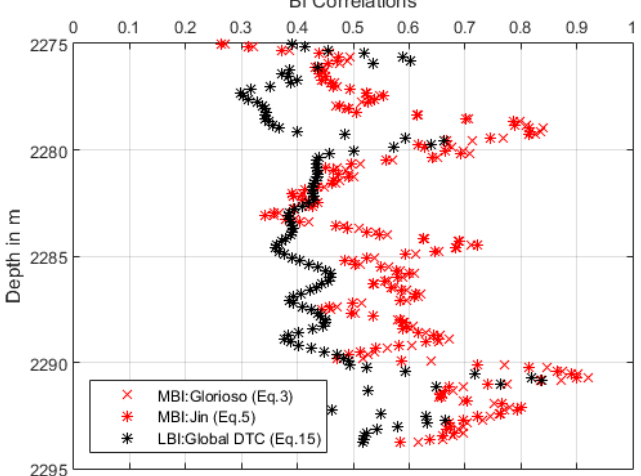
Figure 5. BI correlations from the Marcellus Formation applied over depth. Black colors show LBI correlations and red colors show MBI correlations.